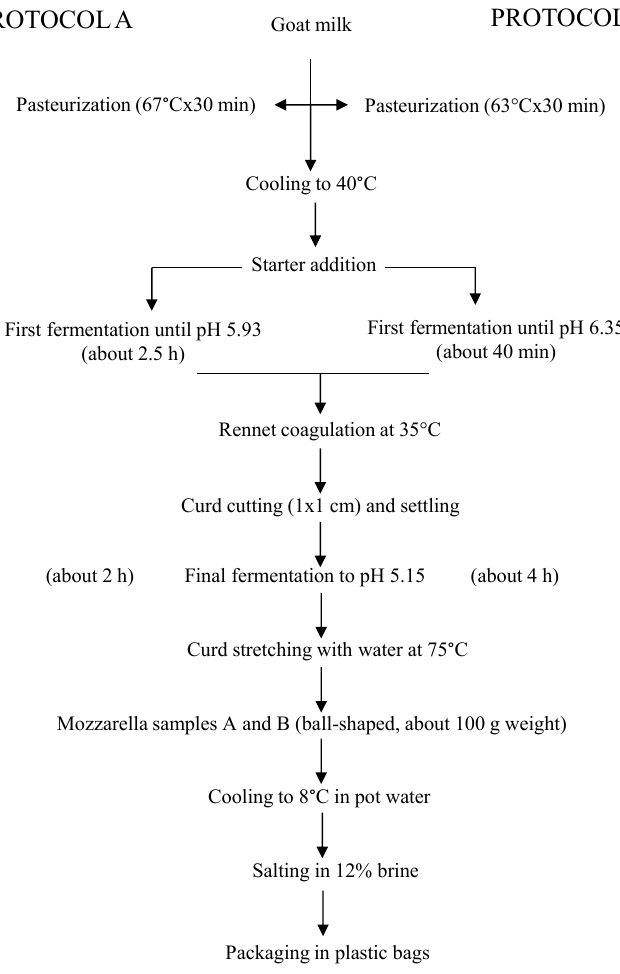
Figure 1. Cheesemaking protocols adopted in the